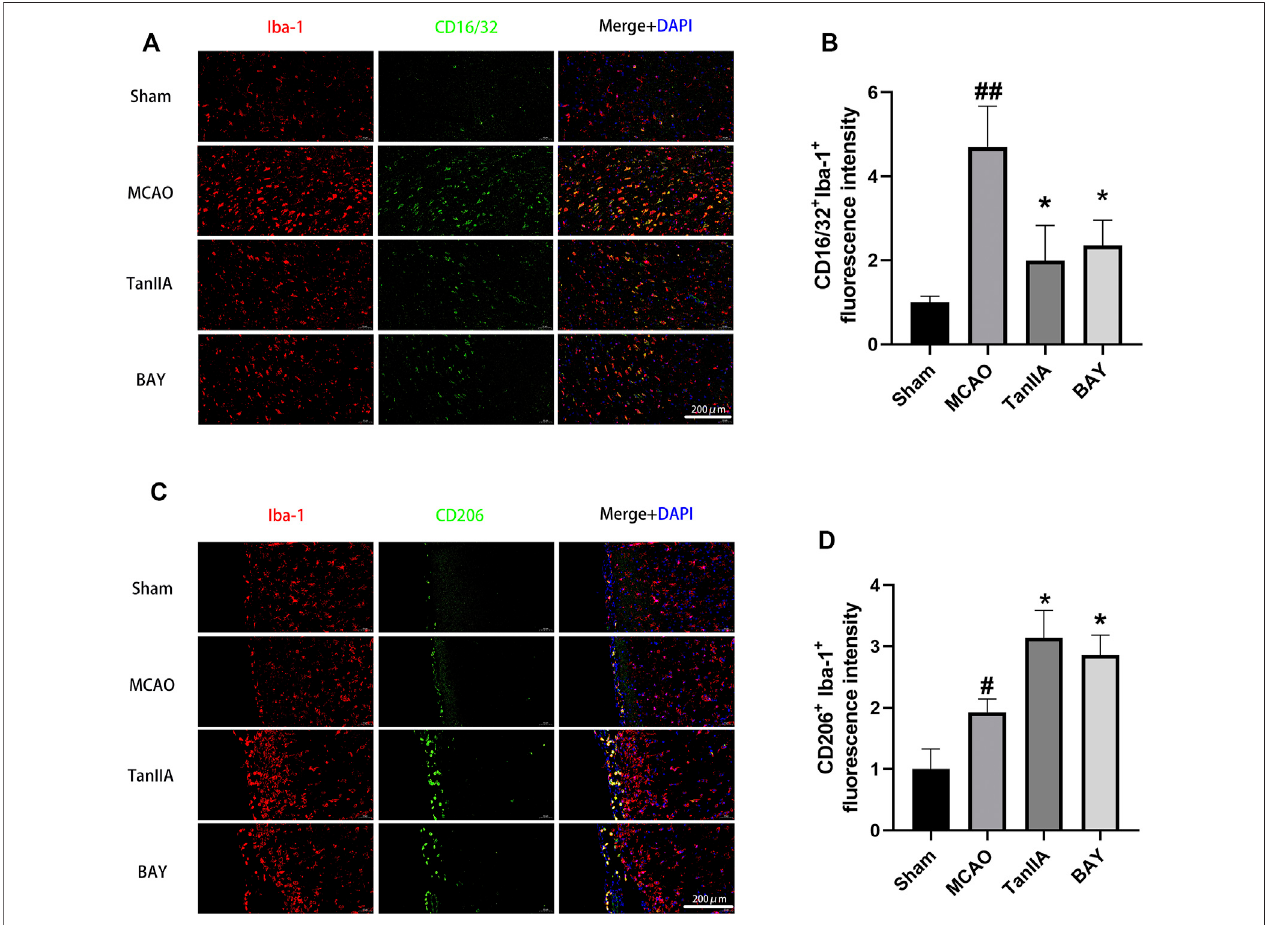
FIGURE 5 | Tanshinone IIA regulated the polarization of microglia in rat cortex. Tanshinone IIA or control saline was injected into the tail vein at the indicated time after MCAO. After reperfusion, the rat brains were harvested. (A) Co-immuno fl uorescence staining of rat brain tissues for microglia marker Iba-1 (red) and M1 marker CD16/32(green), (B) andthelevelofCD16/32 + Iba-1 + cellswereanalyzedandshown. (C) Co-immuno fl uorescencestainingofratbraintissuesformicrogliamarkerIba- 1 (red) and M2 marker CD206 (green), (D) the level of CD206 + Iba-1 + cells were analyzed and shown. ## p < 0.01, compared with the Sham group, * p < 0.05, comparedwiththeMCAOgroup.Sham,shamoperationgroup;MCAO,middlecerebralarteryocclusion;TanIIA,TanshinoneIIA,BAY,BAY-11-7082,aNF- κ Binhibitor, n (cid:1) 3. (Scale bar: 200 μ